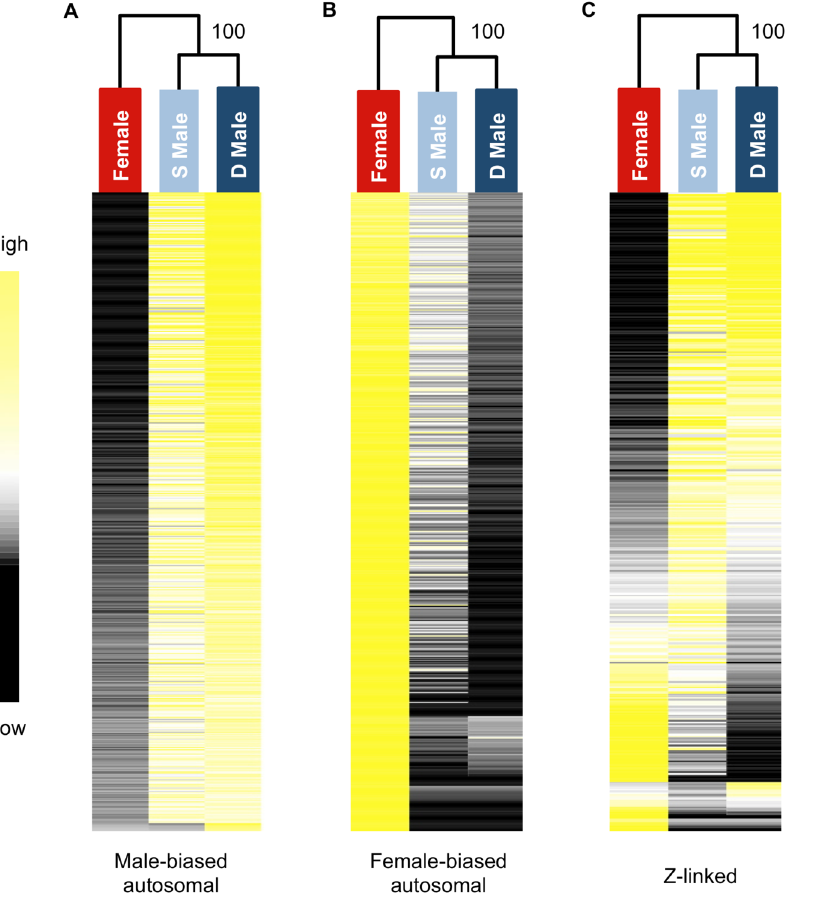
Figure 1. Heat maps and hierarchical clustering of gene expression for females, subordinate males and dominant males. Shown is the relative expression for autosomal male-biased (n=2,217, panel A), female-biased (n=2,908, panel B) and Z-linked (n=364, panel C) genes. Hierarchical gene clustering is based on Euclidean distance for average log 2 expression for each gene for the three sexual morphs. The number at each node is the percentage bootstrap result from 1000 replicates.